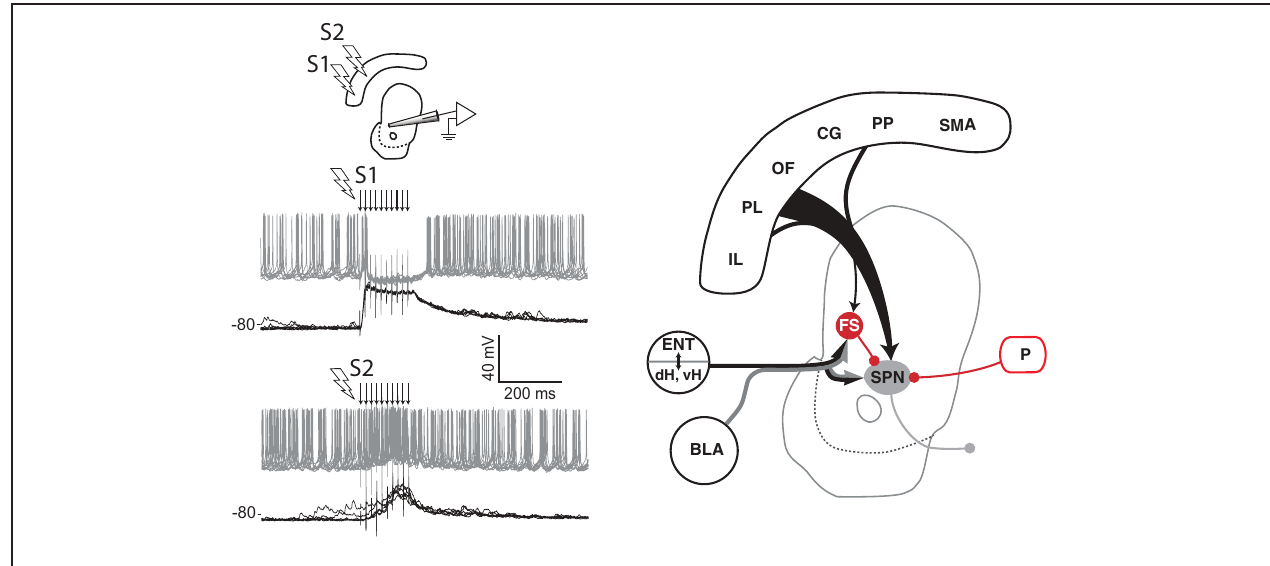
one site (S1) and enhanced by stimulation in another (S2). The latency of the inhibitory component, its reversal potential (not shown), and data from other studies (see text) indicate that feed-forward inhibition from fast spiking (FS) striatalinterneuronsinVSandDMSisalikelysourceofthisinhibition(rightpanel). Abbreviations arethe sameasfor Figure 1 .Adapted fromGruber